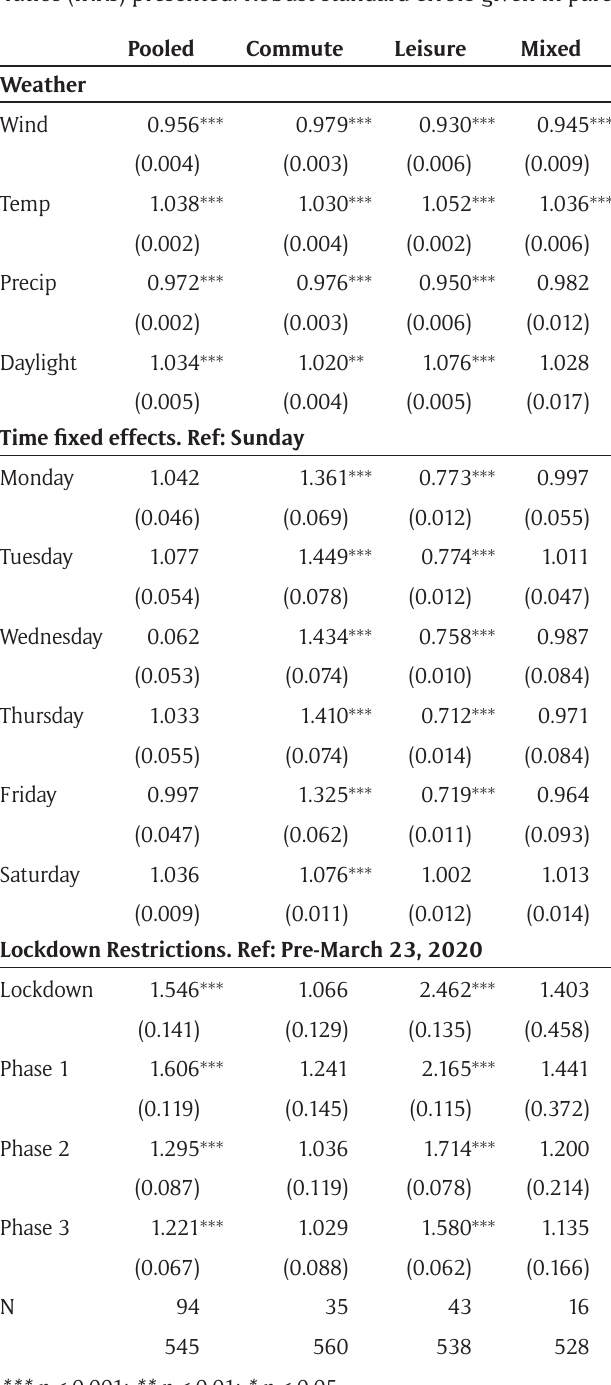
Table 1: Results of Poisson fixed-effect panel data model. Dependent variable: cycle count. Incidence rate ratios (IRRs) presented. Robust standard errors given in